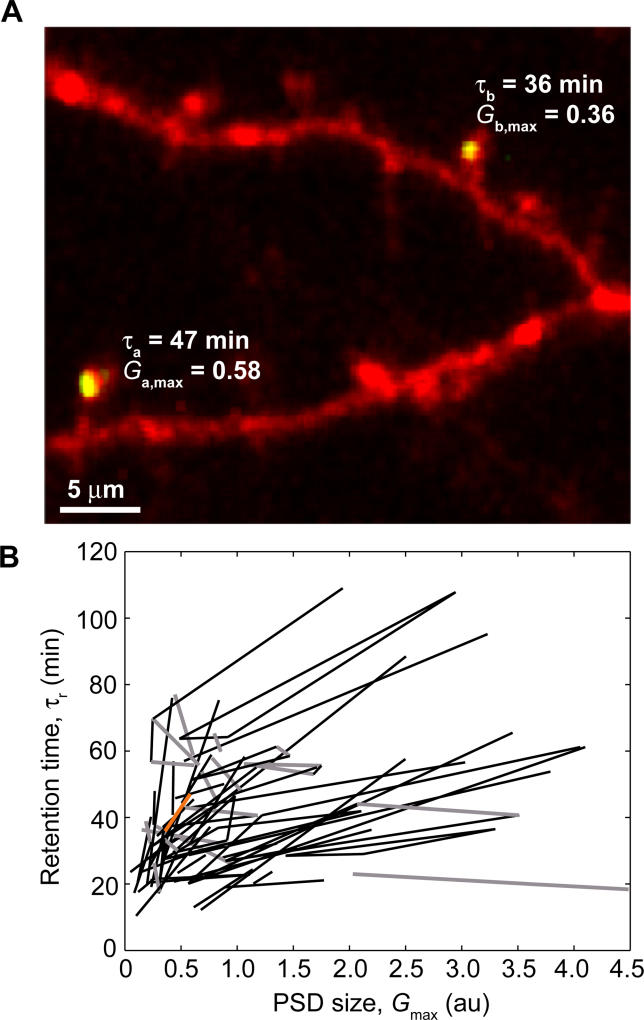
Larger Spines Retain PSD-95 Longer(A) Image of two photoactivated spines, a and b, on two branches of the same dendrite. Ga
,max and Gb
,max are the fluorescence intensities of PSD-95-paGFP* immediately after photoactivation, a measure of PSD size. τ
a
, and τ
b are the corresponding retention times.(B) Comparison of retention times and PSD sizes for pairs of spines. Each line corresponds to a pair of spines, a and b (black, positive slope, n = 64; gray, negative slope, n = 18, 6 animals; orange, example from [A]). Spines with larger PSDs have longer retention times.